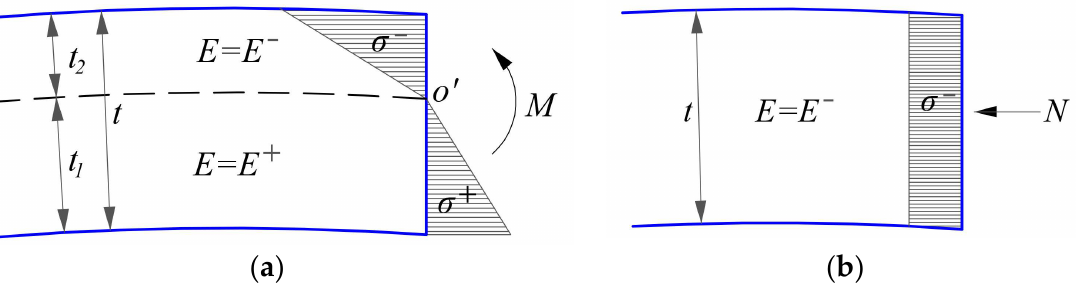
Figure 2. The determination of the tension-compression moduli ( a ) under pure bending and ( b ) under in-plane compressive stress. According to the basic assumptions of the common thin cylindrical shell, the